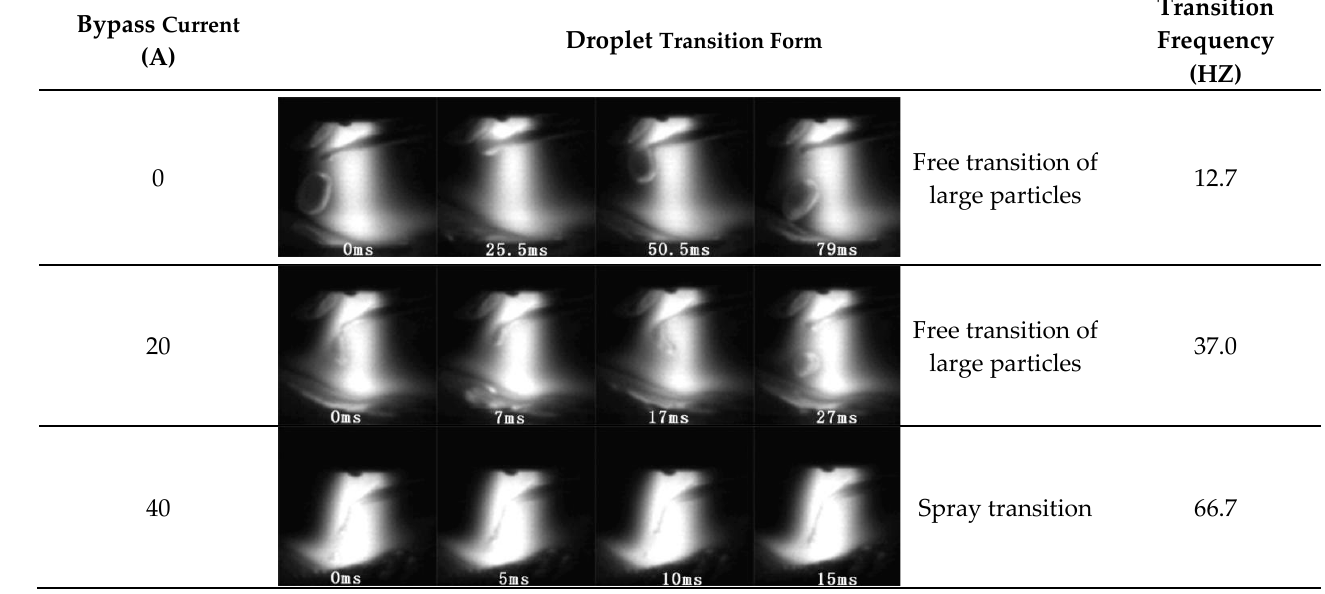
Figure 5. Droplet transfer with the condition of different big bypass current.